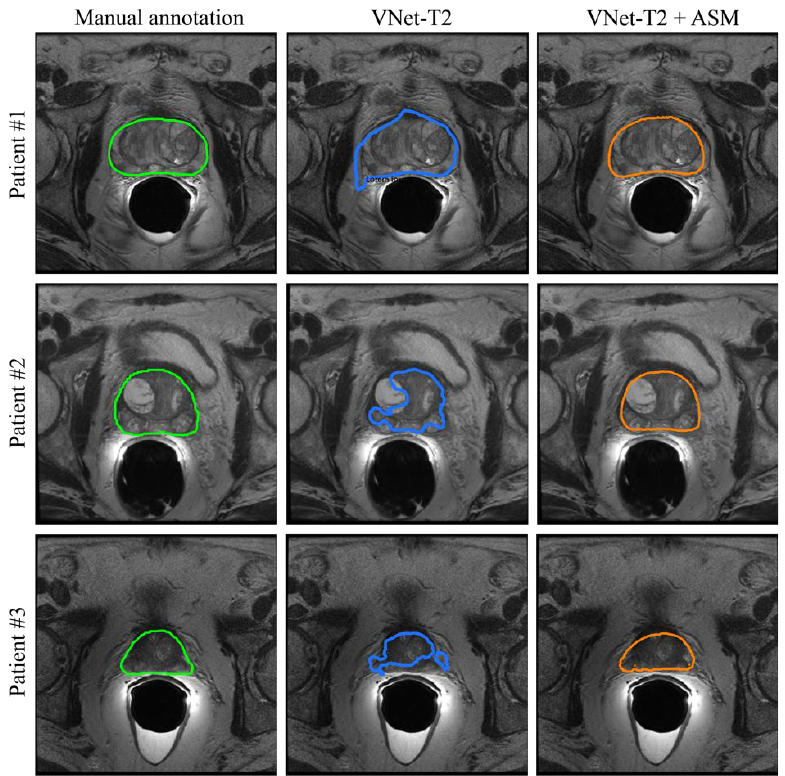
Figure 7. Comparison between manual annotations (first column) and the segmentation obtained for three patients of the test set. The second column shows the results obtained with only the application of the 3D network (VNet-T2) while the ASM refining (VNet-T2 + ASM-2) is illustrated in the last column. Prostate segmentation can be improved by incorporating knowledge of prostate shape variability (ASM) with a deep network prediction.